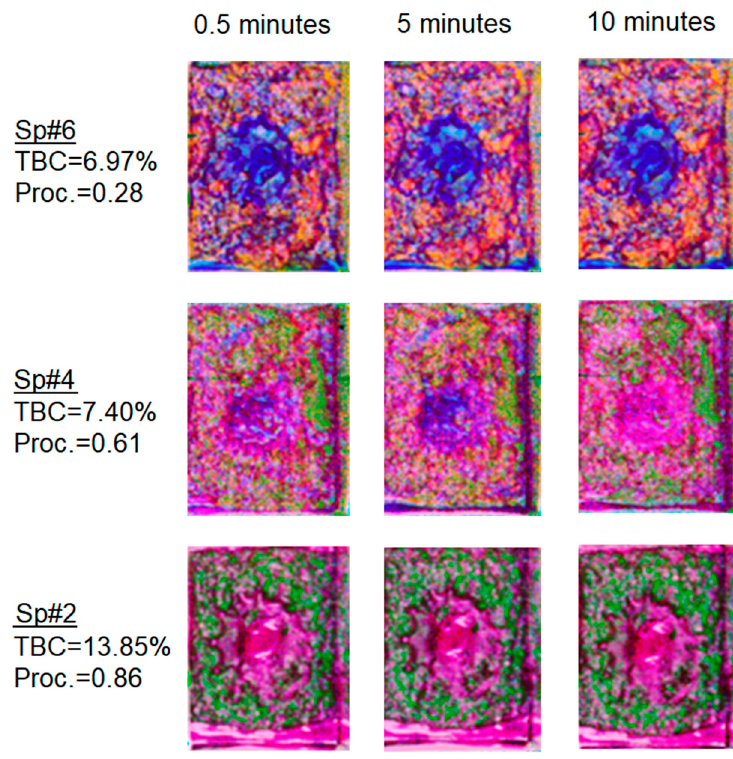
Figure 4. Average point spectra for samples Sp#2, 4, and 6. The spectra are shown with the continuum remove to facilitate the identification of prominent absorption features due to water (W), oil (O), and clay minerals (C). Line patterns: Sp#2 dot-dashed, Sp#4 dashed, Sp#6 solid. Numbers 2, 4 and 6 in the figure are for Sp#2, 4, and 6 respectively.